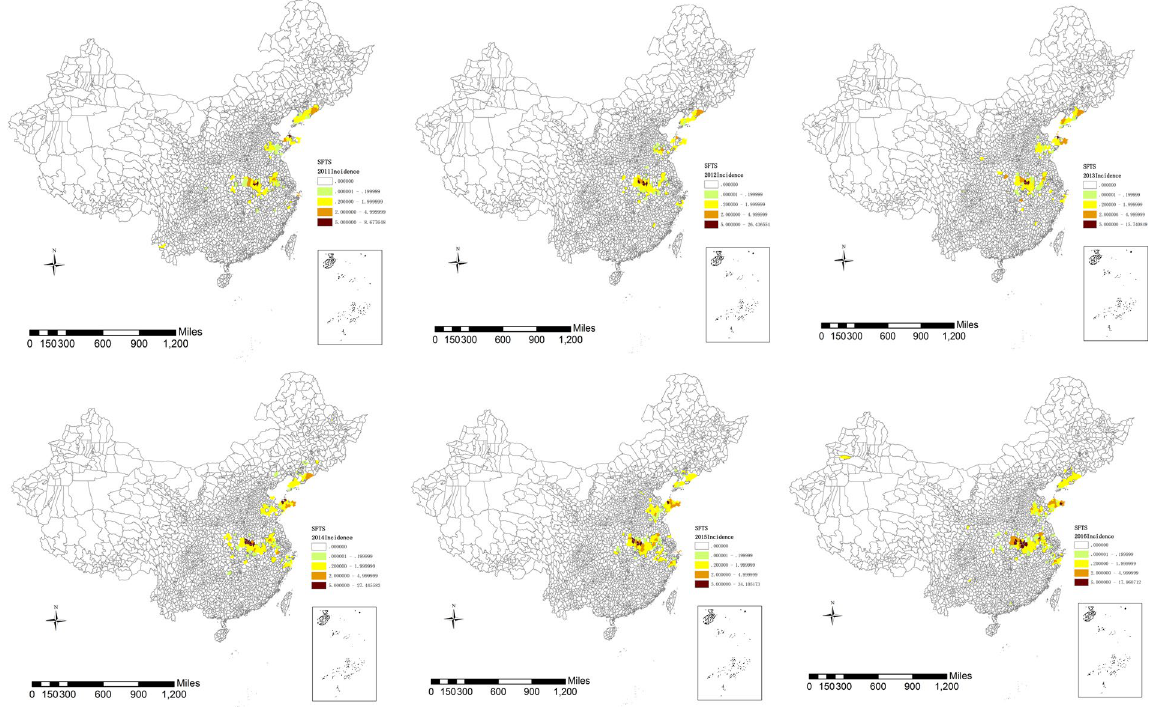
Figure 2. Geographical distribution of SFTS cases in China from 2011 to 2016. These maps were created by ArcGIS software (version 10.1, ESRI Inc.; Redlands, CA, USA). Homepage of ArcGIS software was https://www. esri.com/.